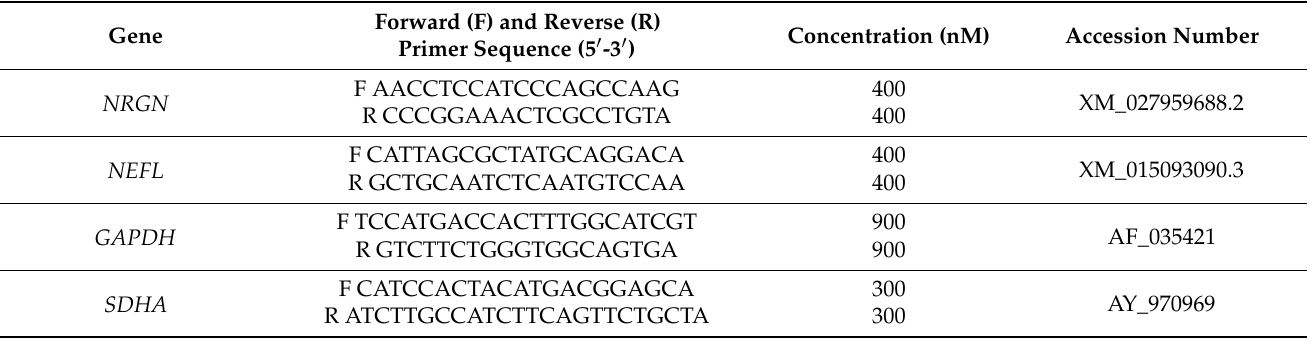
Table 2. Primers used in the gene expression